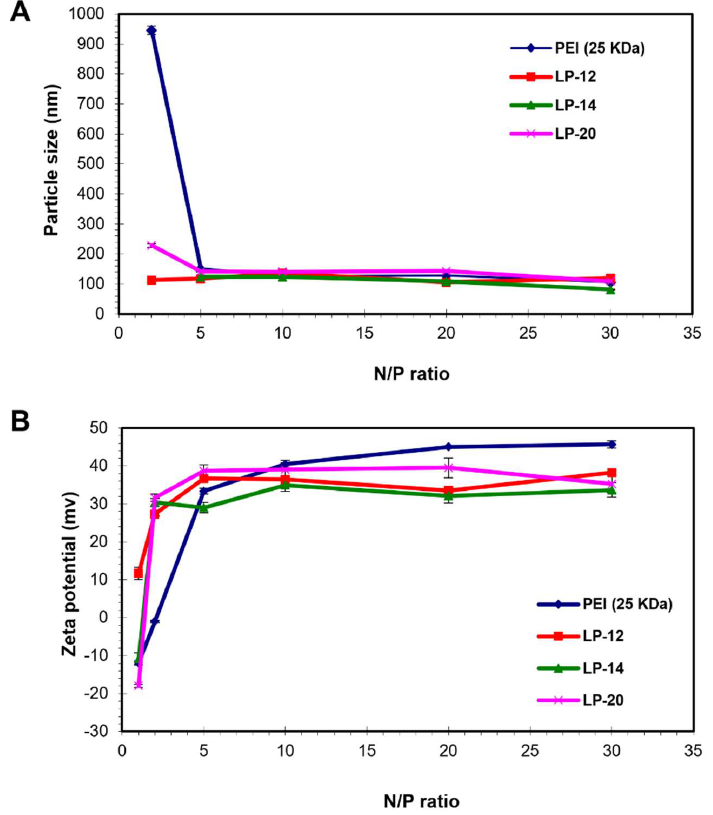
Figure 6. Particle size ( A ) and zeta potential ( B ) of the polyplexes formed between cationic lignin- PDMAEMA carriers (LP-12, LP-14 and LP-20) and pDNA in comparison with PEI/pDNA polyplexes at various N/P ratios. Data represent mean ± standard deviation ( n = 2 for A, n = 3 for B). Data for LP-14 was reported previously [18]